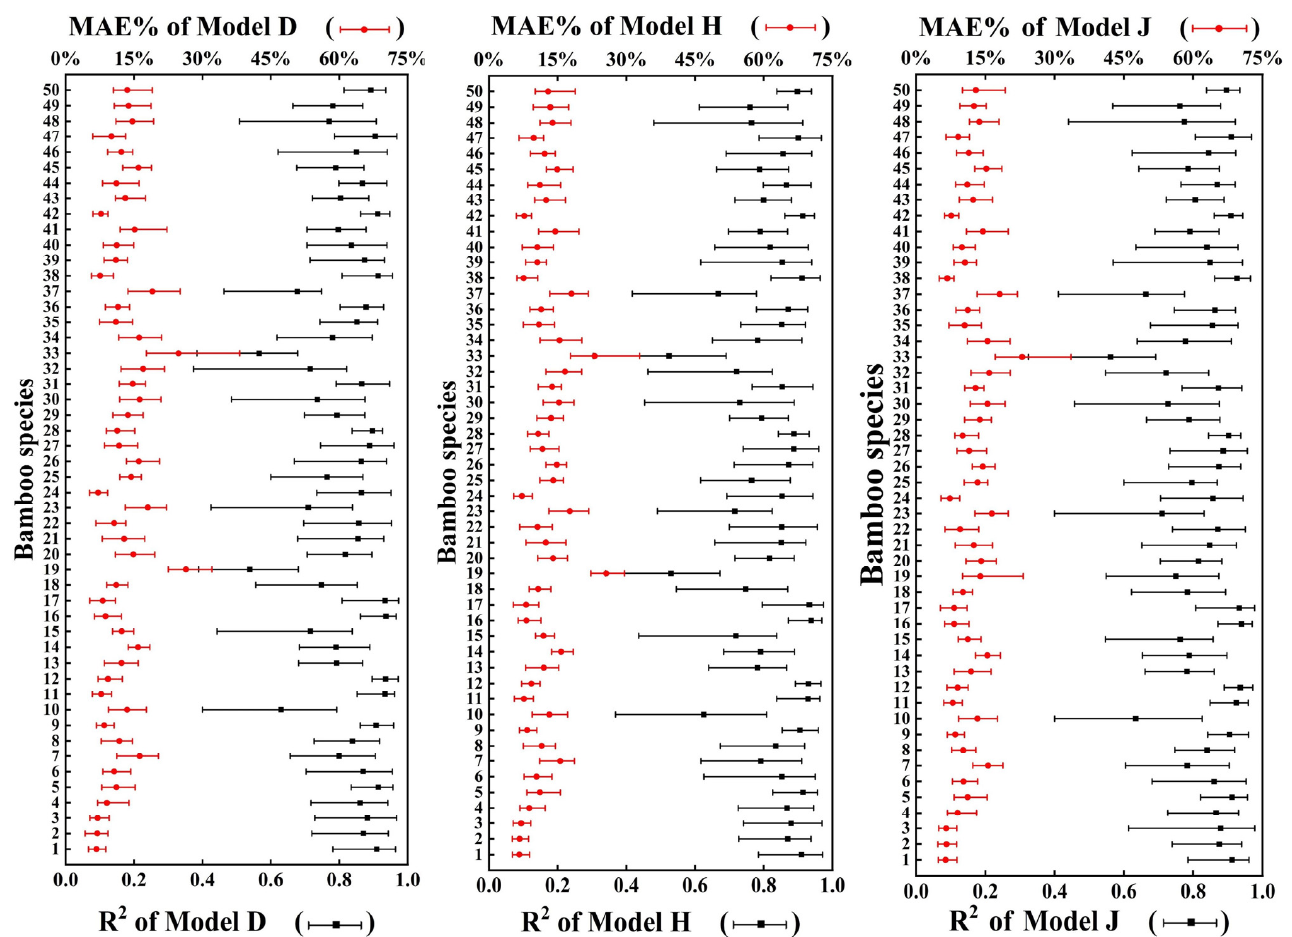
Figure A3. Validation of three selected models for LDM estimations at leaf scale. Black spots and error bars represent the mean value and range of R 2 based on 40 model repetitions. Red spots and error bars represent the mean value and range of MAE % based on 40 model repetitions.